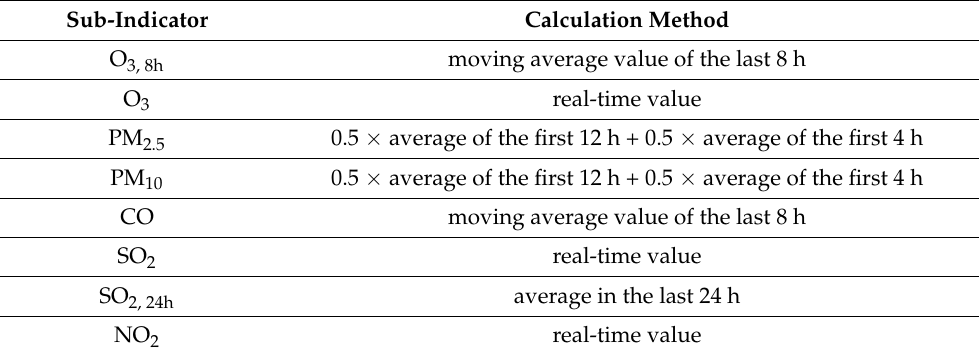
Table 2. AQI’s sub-indicator calculation method